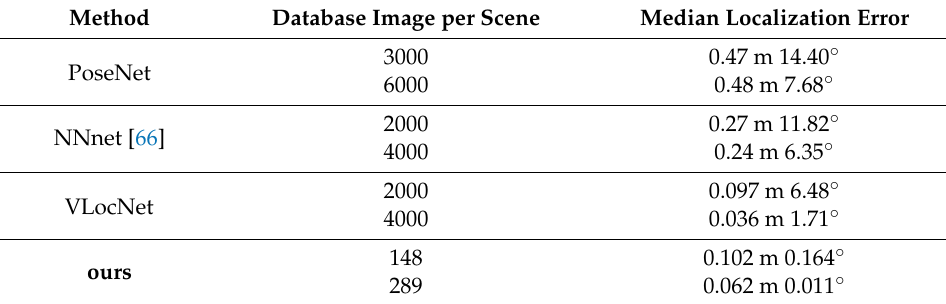
Table 6. Comparison of database